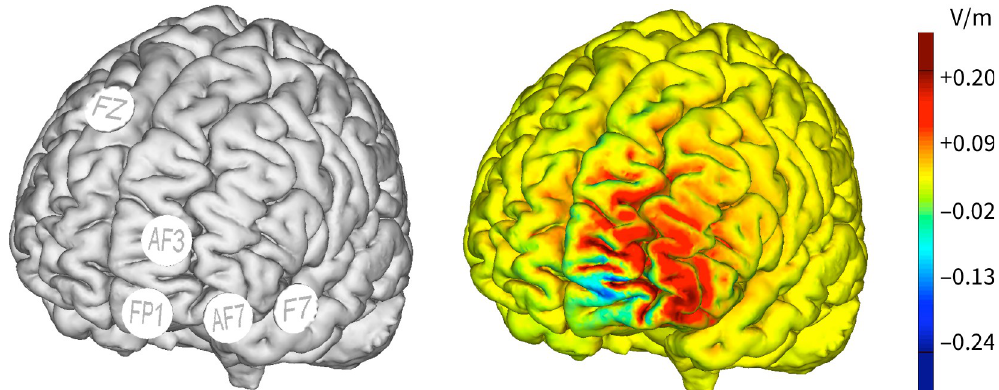
Fig 2. Setup of tDCS stimulation in the NICLab software. Left: Electrode position for multichannel tDCS targeting the left DLPFC. Polarity was defined by the polarity of the AF3 and AF7 electrodes. Right: Modeling of the distribution of the normal component of the E-field during multichannel anodal tDCS stimulation (AF3: 1168 μ A, AF7: 1830 μ A, FP1: –2000 μ A, F7: –749 μ A, FZ: –249 μ A).